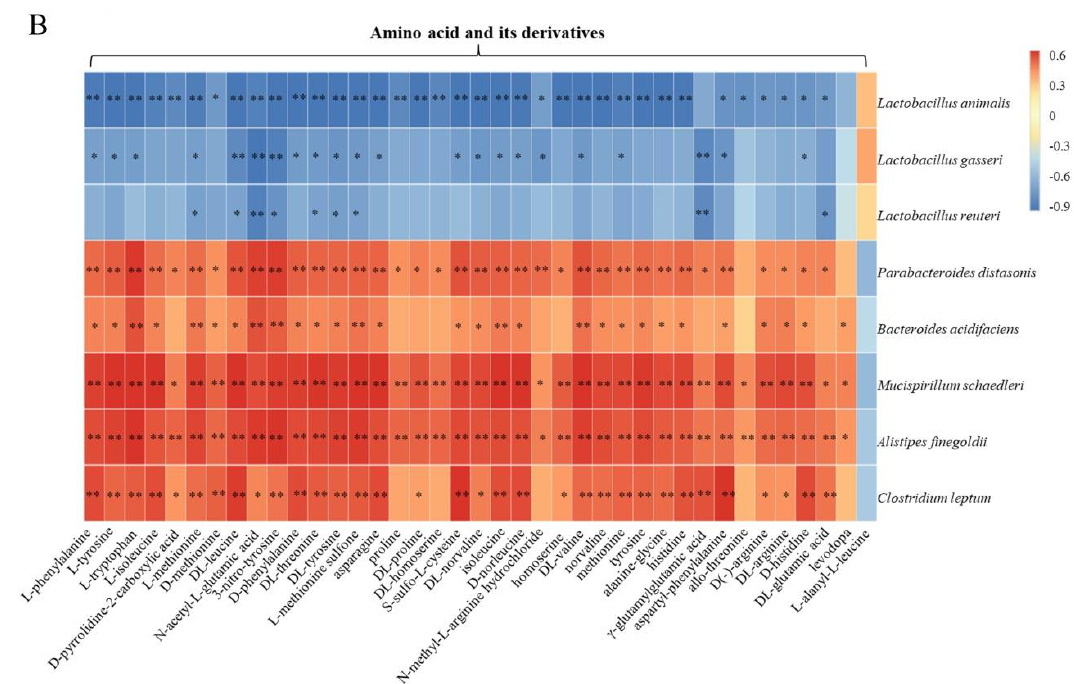
Figure A7. Spearman correlation analysis. ( A ) Correlation analysis between bacterial species and tryptophan-related metabolites, and organic acid and its derivatives. ( B ) Correlation analysis between bacterial species and amino acid and its derivatives. n = 8 for each group. The r value represents the correlation coefficient. * p < 0.05, ** p < 0.01.